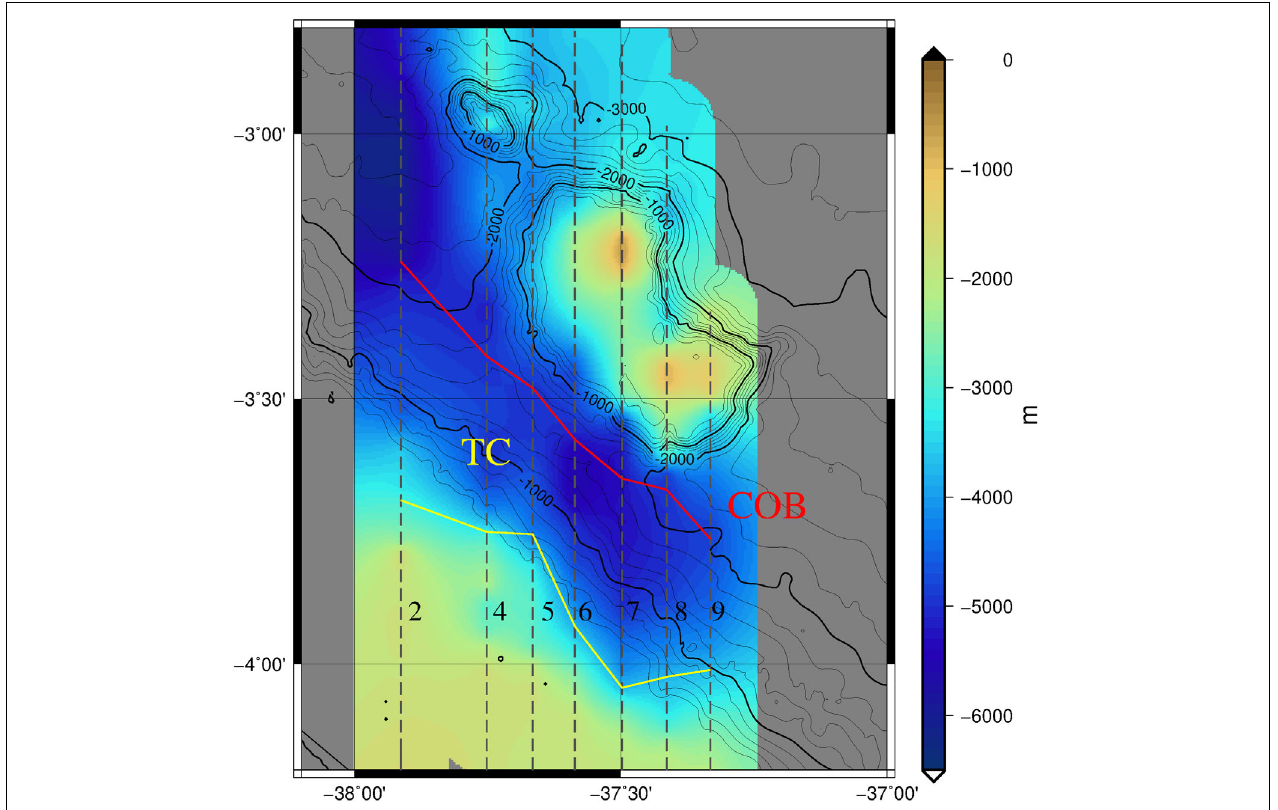
FIGURE 6 | Basement of the Ceará Plateau area from the gravity 2D model. COB: Continental Ocean Boundary, TC: Transitional